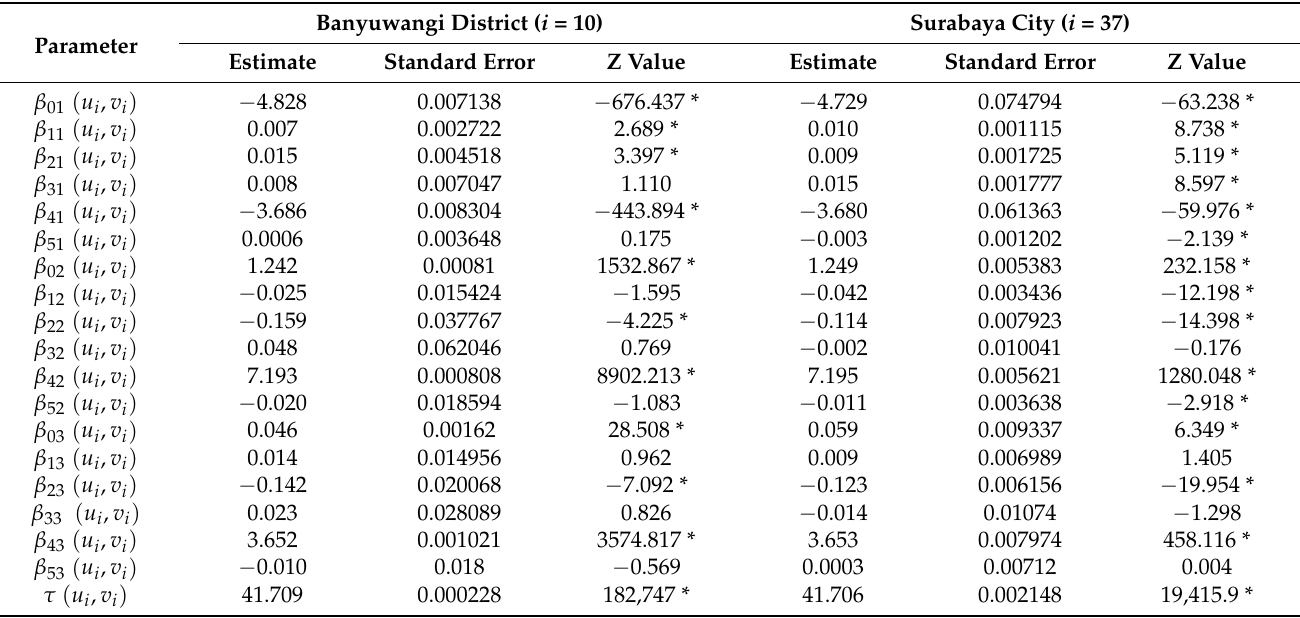
Table 5. Parameter estimate of the GWMPGR model with the fixed Gaussian kernel spatial weighted function for Banyuwangi District ( i = 10) and Surabaya City ( i =